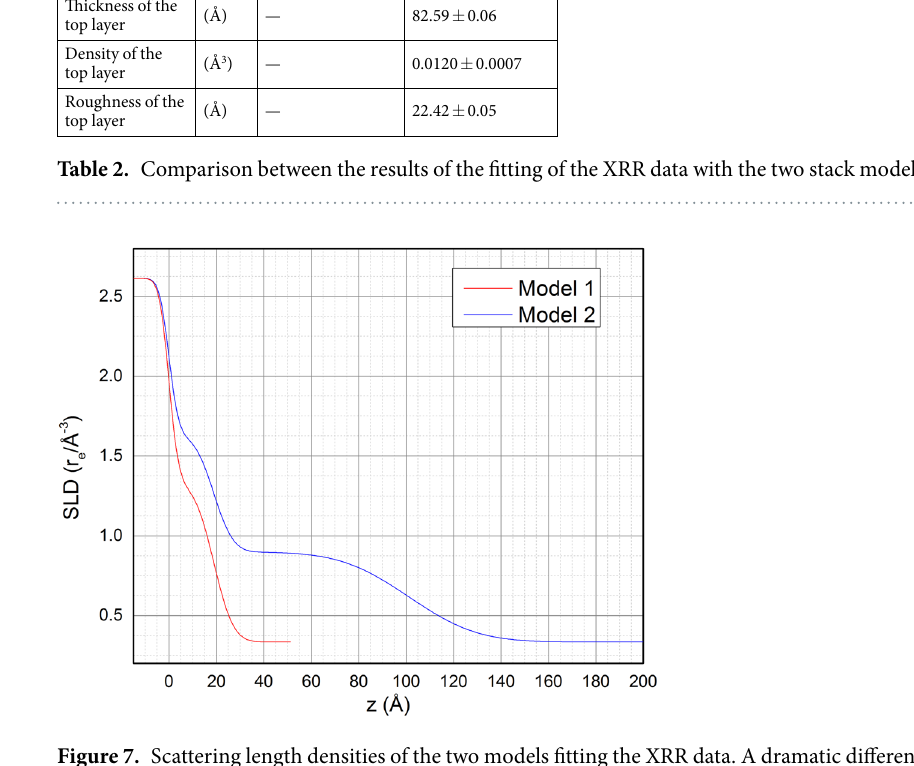
Figure 7. Scattering length densities of the two models fitting the XRR data. A dramatic difference is present for distance higher than 30 Å along